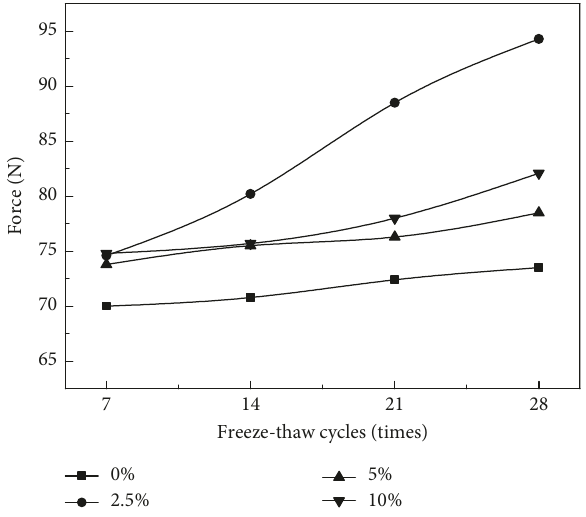
Figure 7: Maximum tensile force of asphalt.